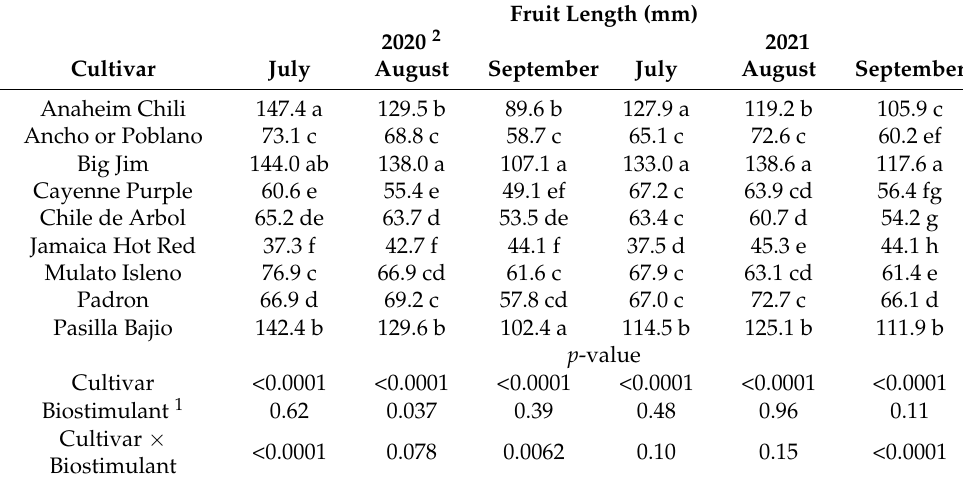
Table 5. Fruit length of nine heirloom chile pepper cultivars grown in a container production system in Starkville, Mississippi, during two growing seasons.